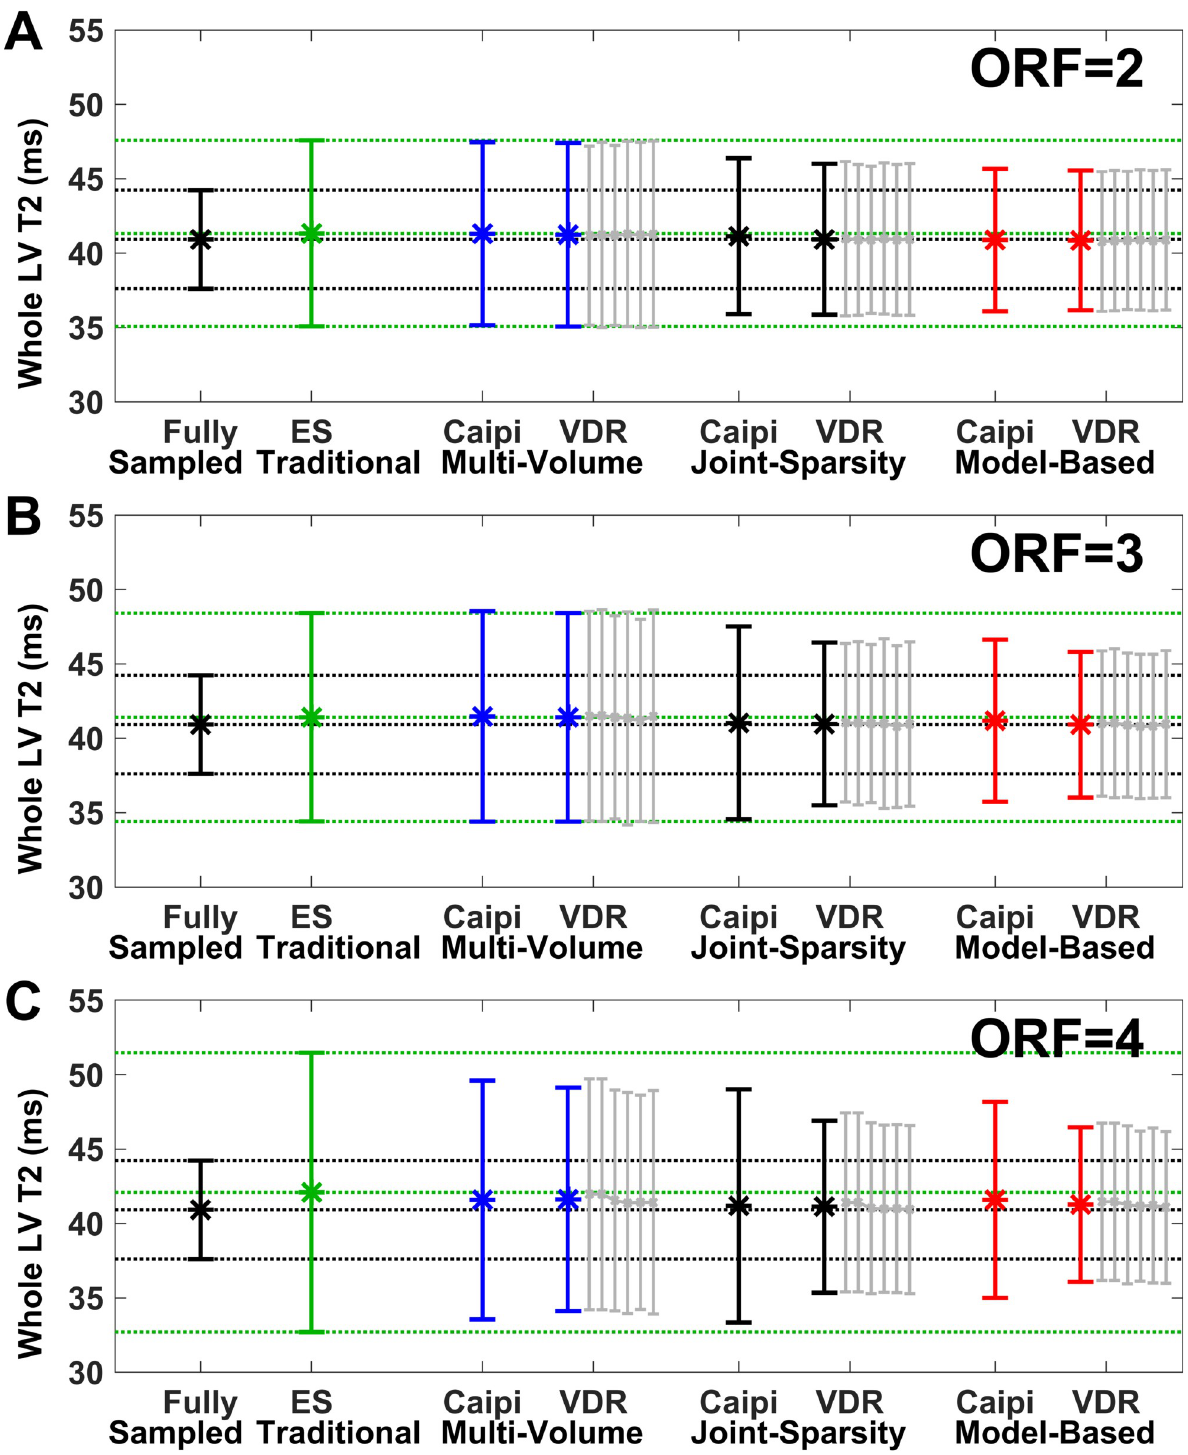
Fig 6. Comparison of the effects of sampling patterns and reconstruction approaches on whole-heart LV T2 mean and SD (error bars) for ORF = 2–4. The subject is the same as shown in Fig 5 and data is displayed using the same conventions as in Fig 4. VDR undersampling outperformed Caipi undersampling at all